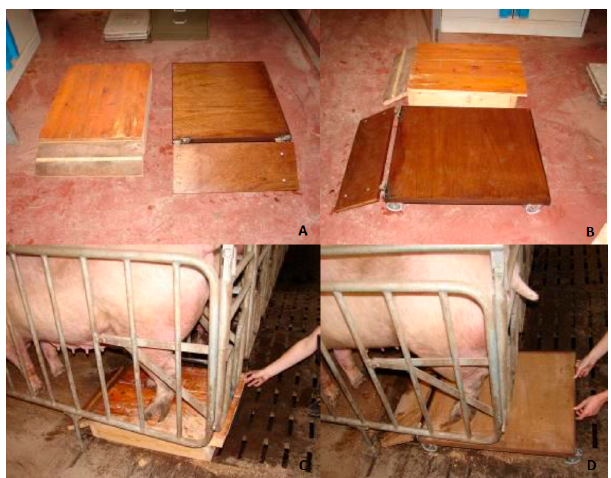
Figure 2. First and second wooden prototypes of the Mobile Claw Scoring Device (MCSD). ( A , B ) = top and side views of the prototypes. The left MCSD is the first and the right MSCD the second prototype. ( C ) The first wooden prototype tested in a gestation crate. ( D ) The second wooden prototype tested in a gestation crate.